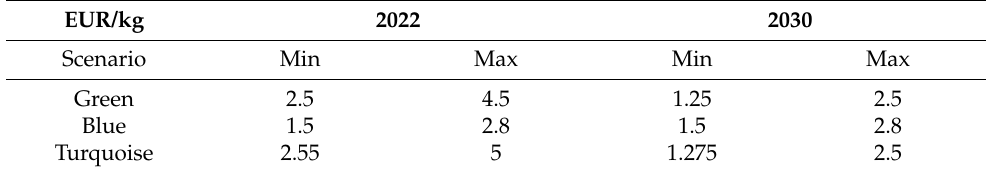
Table 1. Cost structure of hydrogen according to